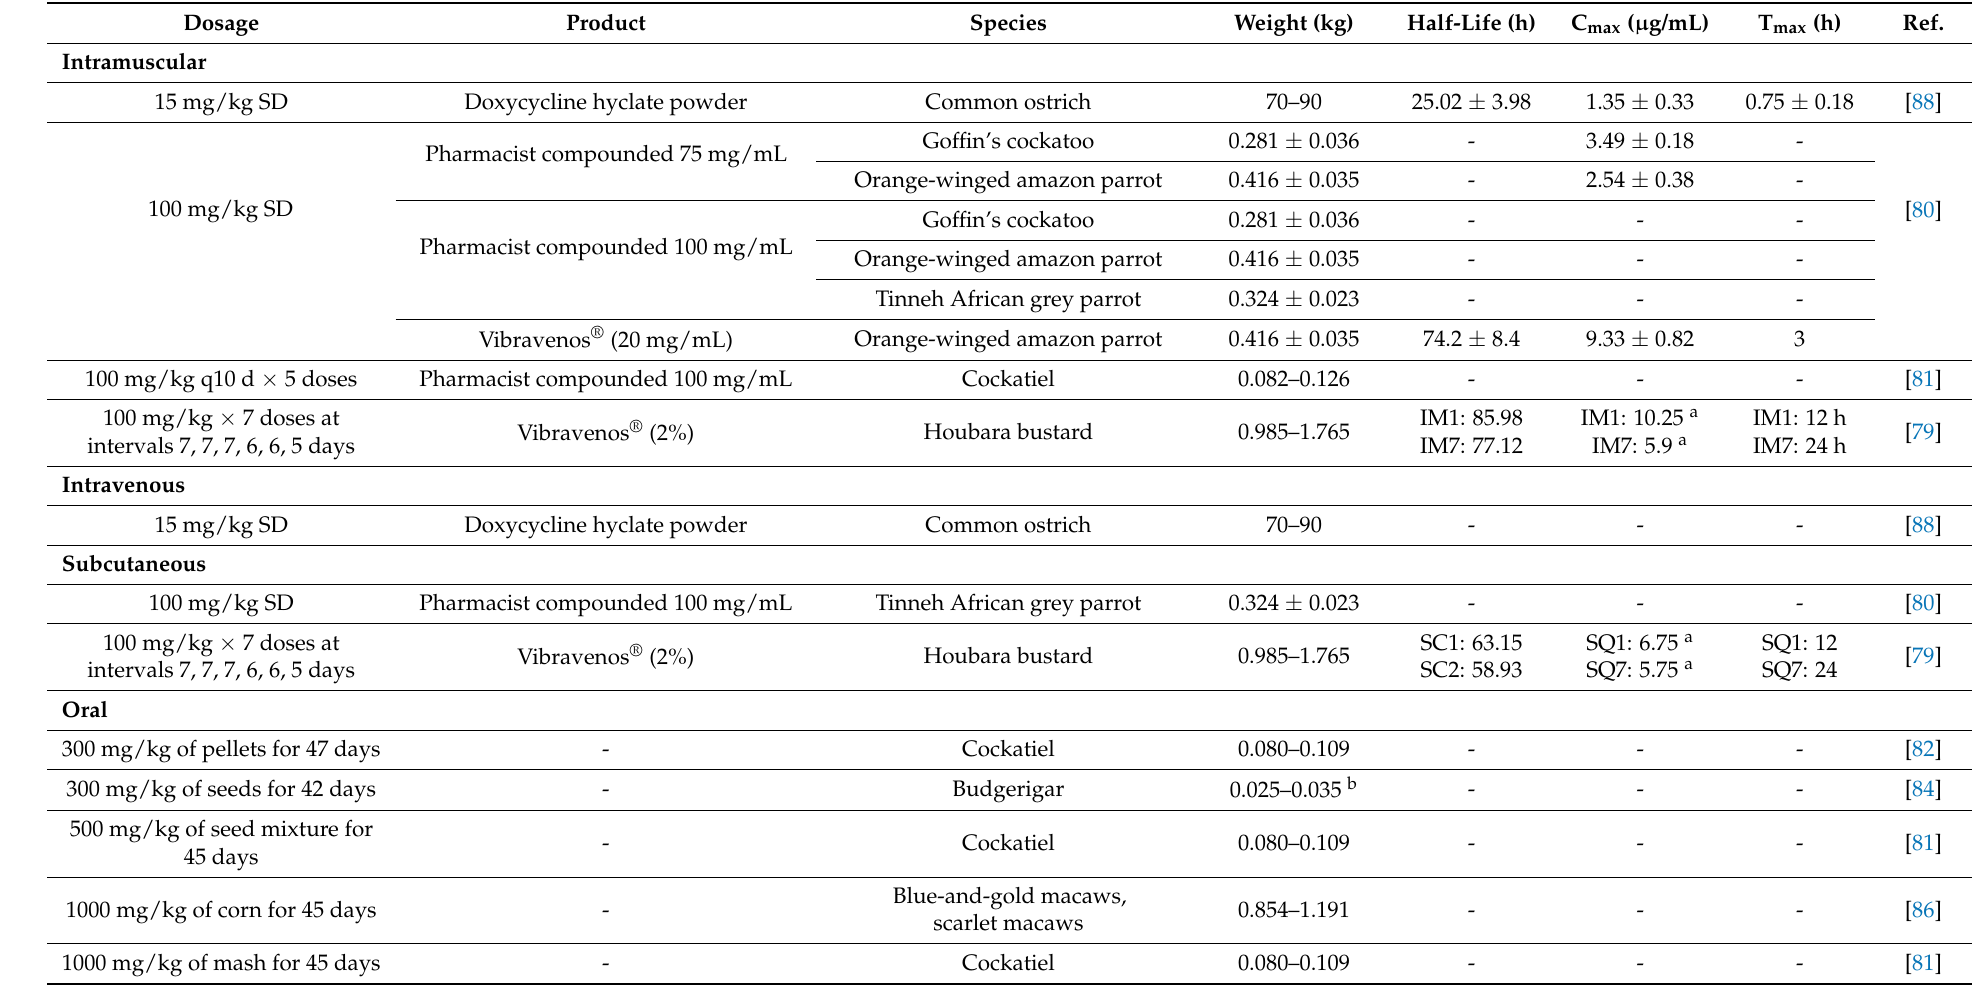
Table 13. Pharmacokinetic values for doxycycline in exotic avian